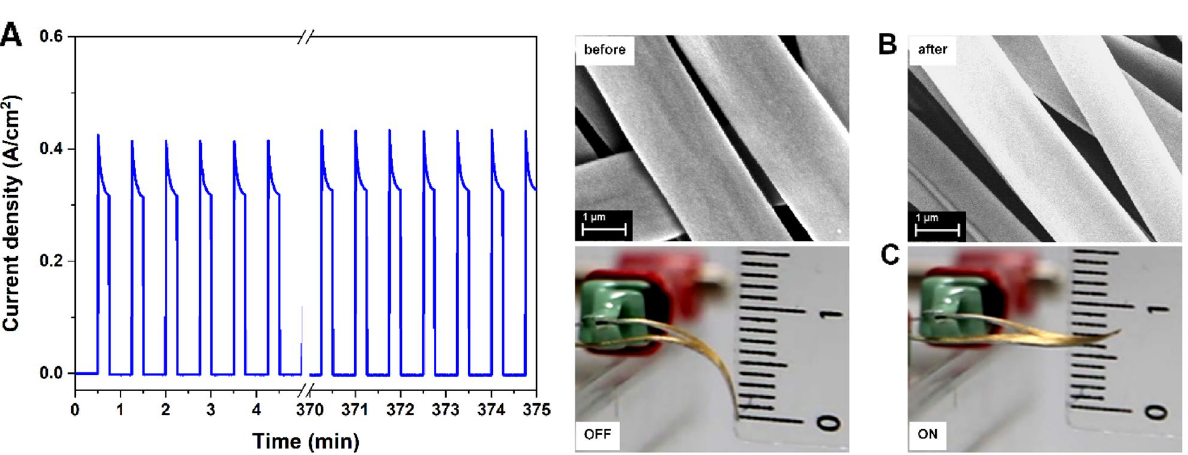
Figure 5. Artificial muscle life time. ( A ) The current density registered for 500 actuation cycles; ( B ) SEM images of the metalized electrospun fiber network attached on PDMS sheet before and after 500 ON/OFF voltage cycles; ( C ) Snapshots taken after 500 actuation cycles of the artificial